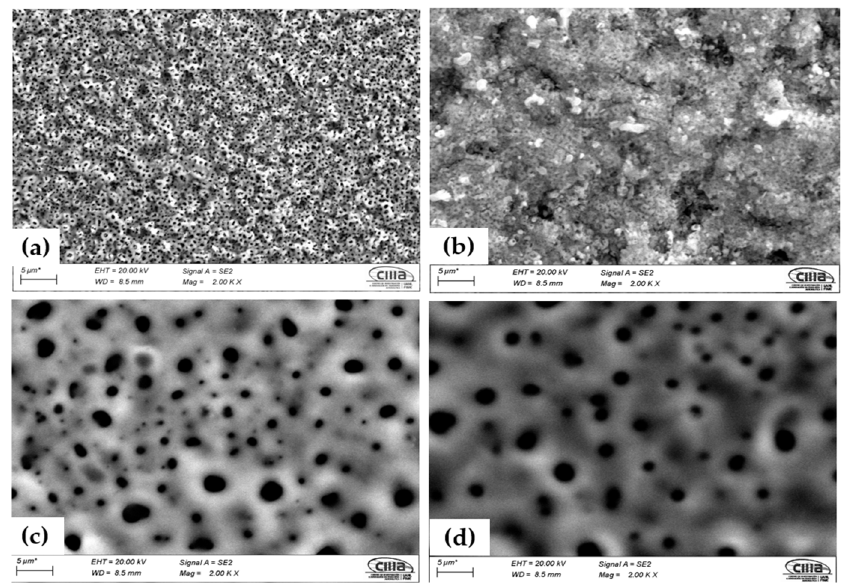
Figure 2. Micrographs of the anodized samples by SEM-SE. The sample anodized in H 2 SO 4 ( a ) Ti- 6Al-2Sn-4Zr-2Mo and ( b ) Ti-6Al-4V; in H 3 PO 4 ( c ) Ti-6Al-2Sn-4Zr-2Mo and ( d ) Ti-6Al-4V.